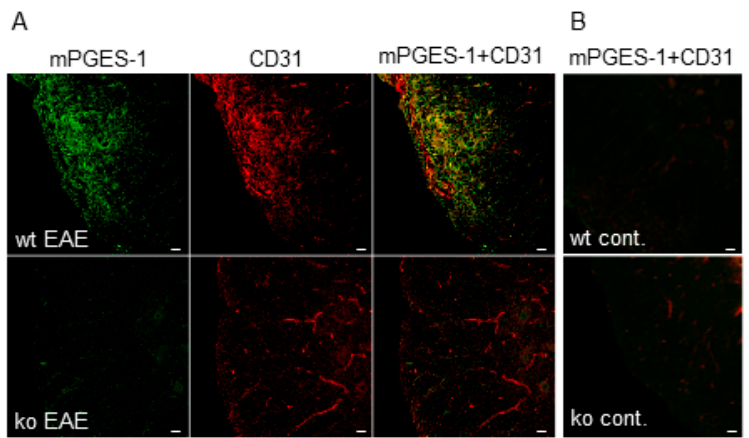
Figure 1. Expression of microsomal PGE synthase-1 (mPGES-1) in CD31-positive (CD31 + ) endothelial cells (ECs). Immunohistochemical staining of mPGE-1 (green) with CD31 (red) in the inflammatory regions of spinal cords of wild-type (wt) experimental autoimmune encephalomyelitis (EAE) mice and mPGES-1 -deficient ( mPGES-1 − / − ) EAE mice ( A ) and in the spinal cords of wt control mice and mPGES-1 − / − control mice ( B ). Scale bars, 20 µ m (for all images); wt, wild-type; ko, mPGES-1 − / − ; cont., naïve mice; EAE, EAE mice.